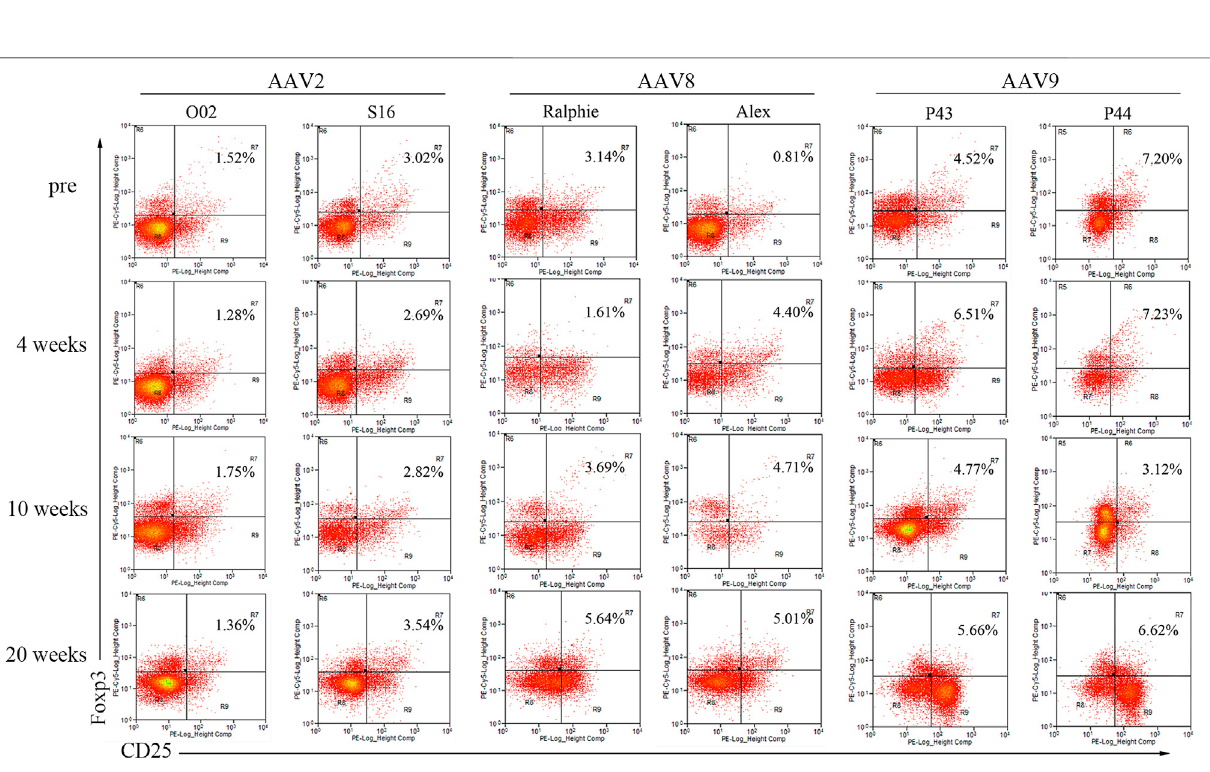
Frontiers in Pharmacology |